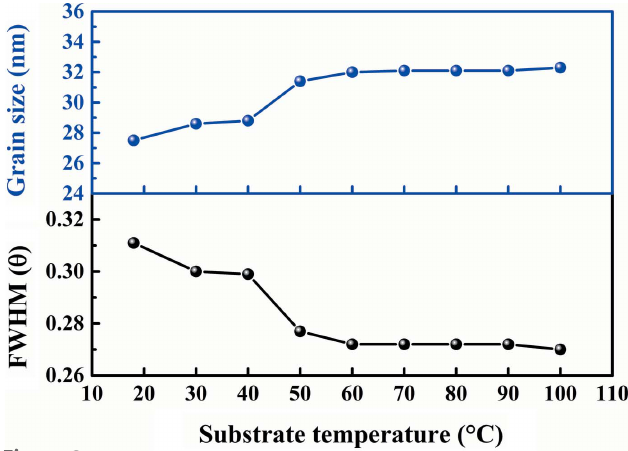
Figure 3 The FWHM and out-of-plane grain size as a function of Bi thin films for substrate temperatures (the growth rate is 1.61 A˚ min (cid:5) 1 and the deposition time is 240